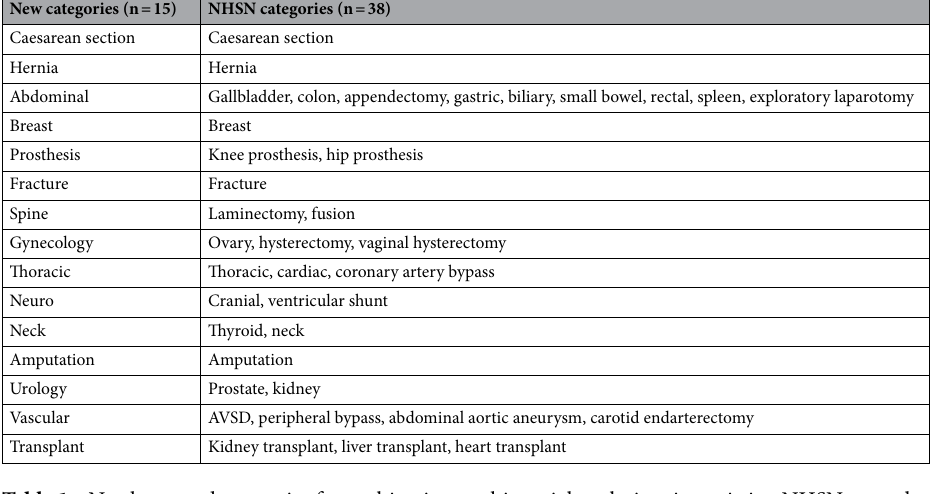
Table 1. Newly created categories for multivariate multinomial analysis using existing NHSN procedure category groups for SSI monitoring. The NHSN pacemaker group was omitted from analysis. AVSD: Shunt for